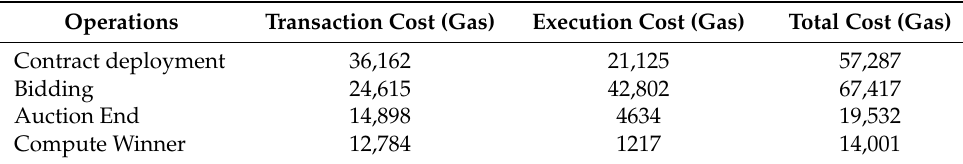
Table 1. Summary of transaction costs.